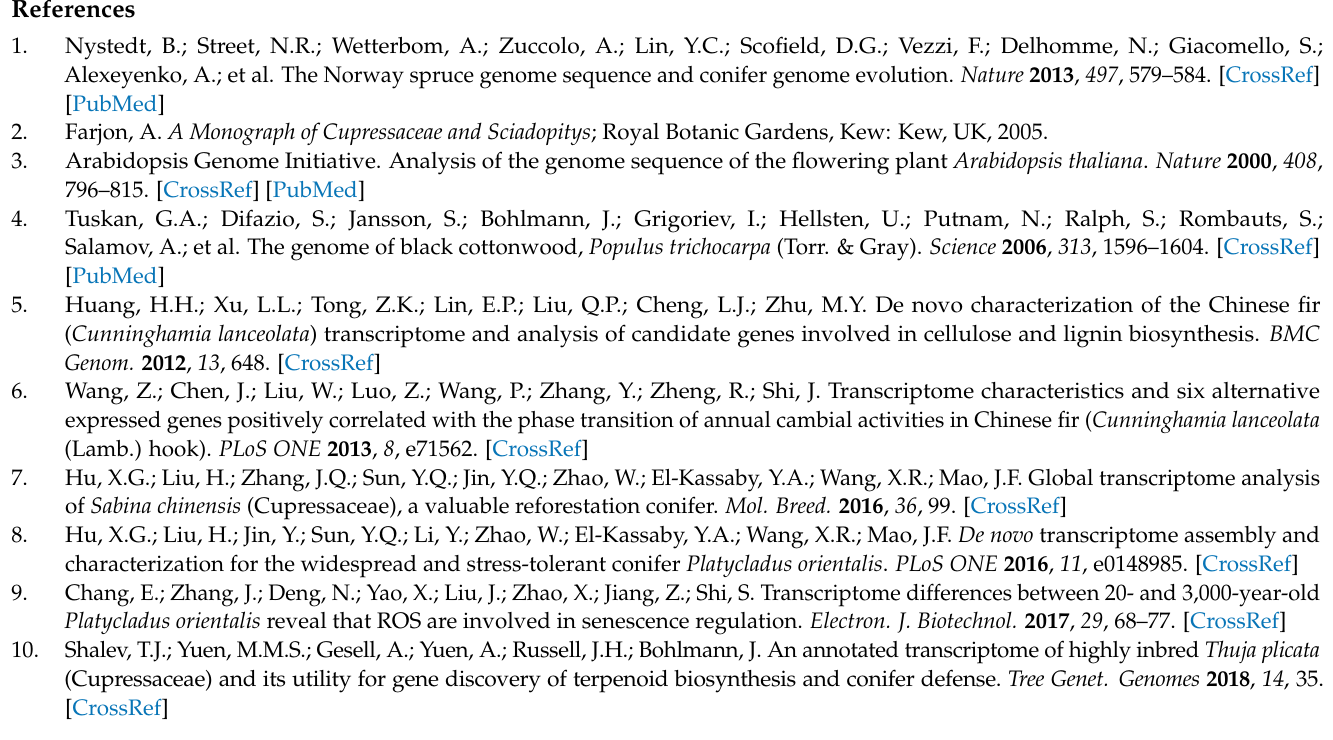
sequences used for RT-PCR